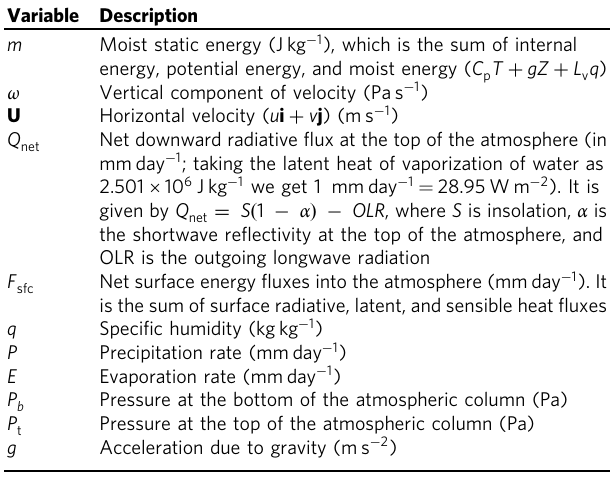
Table 1 De fi nition of